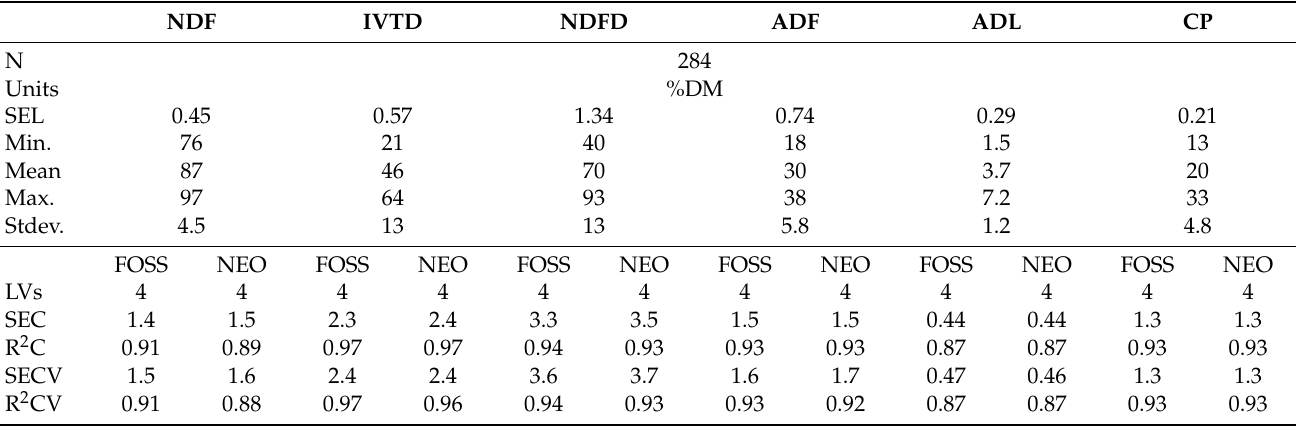
Table 1. Statistics of calibration results for predicting forage nutritive value from a model that combines data from fresh alfalfa (N = 104) and fresh grass (N = 180) samples using the NIRSystems 6500 (FOSS), and the NeoSpectra-Scanner handheld instrument